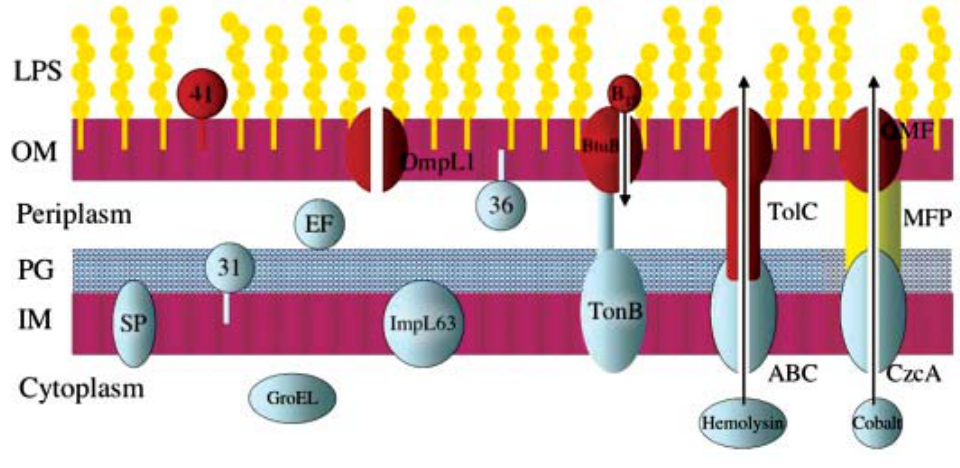
Figure 6. Model of leptospiral membrane architecture. Leptospires have two membranes, an outer membrane (OM) and a cytoplasmic or inner membrane (IM). As in Gram-positive bacteria, the peptidoglycan (PG) cell wall is closely associated with the IM. The leptospiral surface is dominated by lipopolysaccharide (LPS) carbohydrate side chains. Subsurface proteins include the cytoplasmic protein, GroEL, and the periplasmic endoflagella (EF). The IM contains lipoproteins such as LipL31 and transmembrane proteins such as signal peptidase (SP) and ImpL63. The OM contains lipoproteins including LipL41 and LipL36, and transmembrane proteins including the porin, OmpL1. Genomic sequence analysis reveals several novel types of outer membrane proteins (OMPs), including TonB- dependent OMPs involved in nutrient acquisition. BtuB is an example of a TonB-dependent OMP involved in uptake of vitamin B 12 . The type I efflux system is represented by TolC, which forms a complex with ATP-binding cassette (ABC) transporters to export hemolysins and other cytoplasmic components. The leptospiral genome also contains genes involved in a three-component efflux system consisting of an outer membrane factor (OMF), membrane fusion protein (MFP), and an inner membrane transporter, in this case CzcA, which is involved in heavy metal